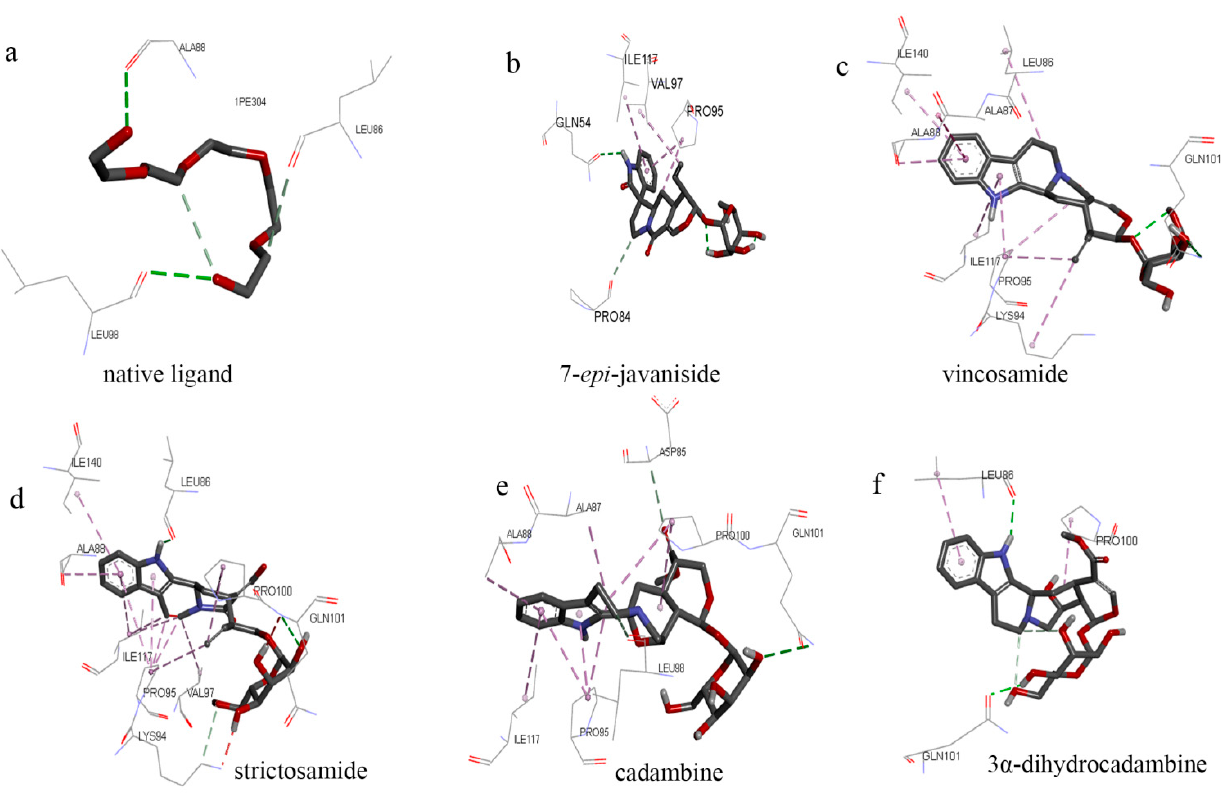
Figure 6. Three-dimensional (3D) figures of molecular docking between compounds 1 – 5 and AchE (( a ), native ligand; ( b – f ), compound 1 – 5 ). (( a ), native ligand; ( b – f ), compounds 1 – 5